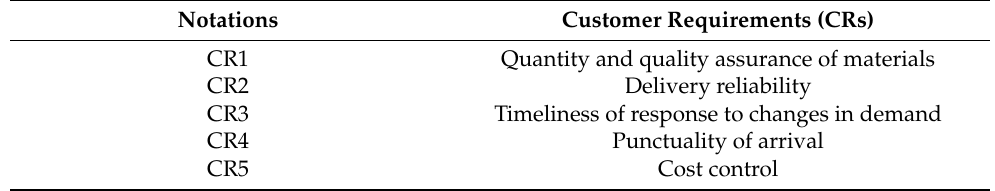
Table 2. CRs for supply chain of shipbuilding